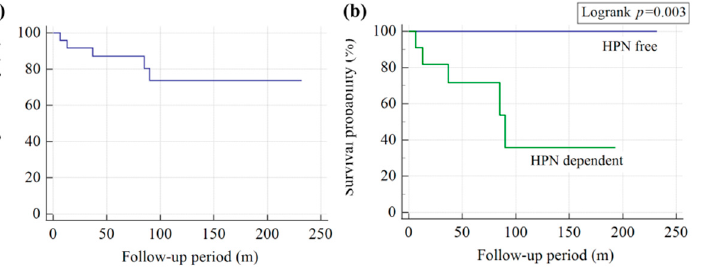
Figure 2. ( a ) Kaplan–Meier survival curve of all-cause mortality in HPN patients. ( b ) Comparison